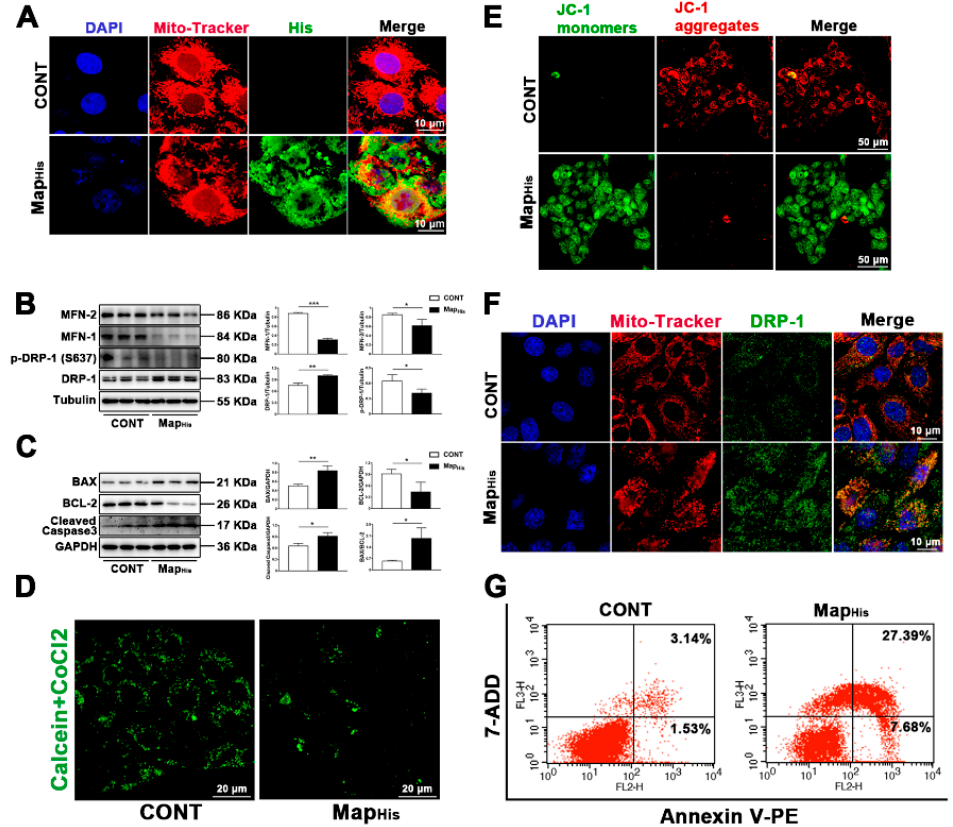
Figure 6. Map, as a virulence factor of E. coli (EPEC), is sufficient to induce mitochondrial fission and apoptosis. ( A ) Map localization to mitochondria. MAC-T cells were stained with anti-His (Map) antibody, mitochondria (Mito-Tracker, red), and DAPI (blue, nucleus). Scale bar, 10 µ m. ( B ) The DRP-1, p-DRP-1 (ser637), MFN-1, and MFN-2 levels were analyzed by Western blot. ( C ) The BAX, BCL-2 and cleaved caspase-3 levels were analyzed by Western blot. ( D ) The mPTP kit was used to detect the opening of mPTP. Scale bar, 20 µ m ( E ) JC-1 was used to analyze the MMP. JC-1 monomers, green. JC-1 aggregates, red. Scale bar, 50 µ m. ( F ) DRP-1 translocated to the mitochondria. Cells were stained with anti-DRP-1 (green), mitochondria (Mito-Tracker, red), and DAPI (blue, nucleus). Scale bar, 10 µ m. ( G ) The apoptosis rate was determined by Annexin V-PE/7-ADD staining assay. The pc DNA3.1 plasmid with map was synthesized by the Sykmgene Company, and the His tag was synthesized on the plasmid (Map His plasmid). Map His plasmid diluted with Lipofectamine™ 3000 was transfected into the cells. Representative images are shown. Data are from 3 independent experiments and presented as the mean ± SEM; * p < 0.05, ** p < 0.01 *** p <